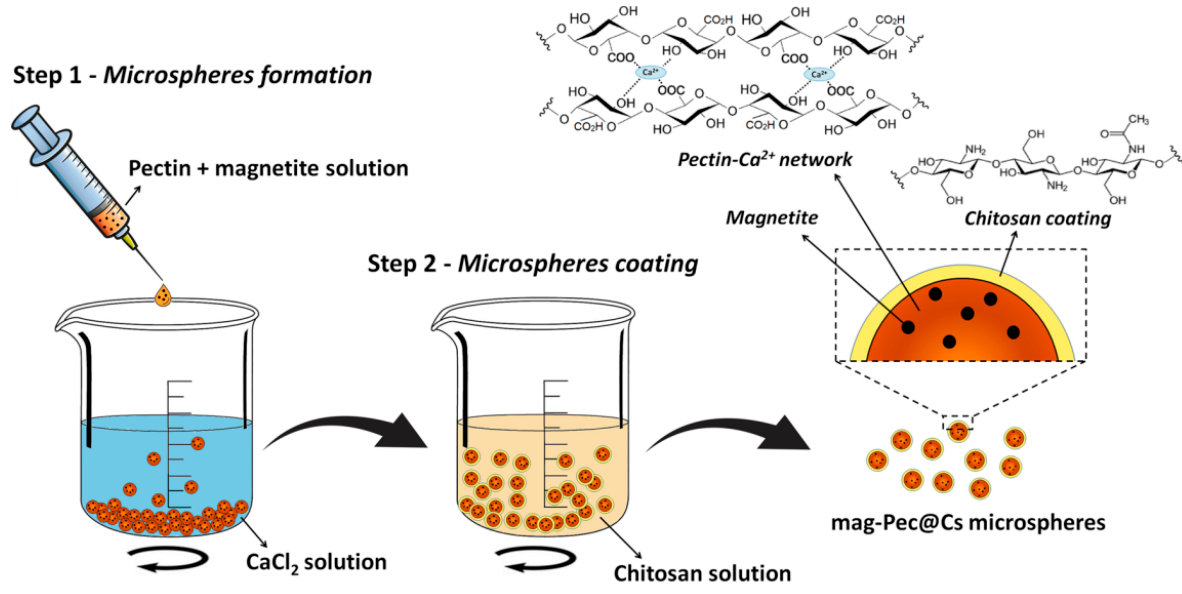
Figure 7. Scheme for the illustration and formation of magnetic Pec microspheres coated with chitosan. Reproduced with permission [66].